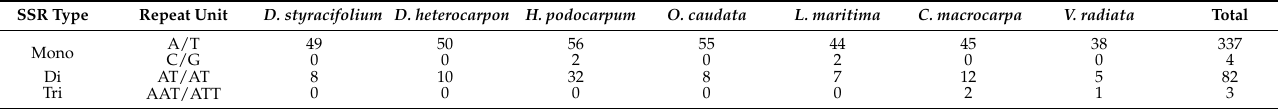
Table 3. Type and number of SSRs in the chloroplast